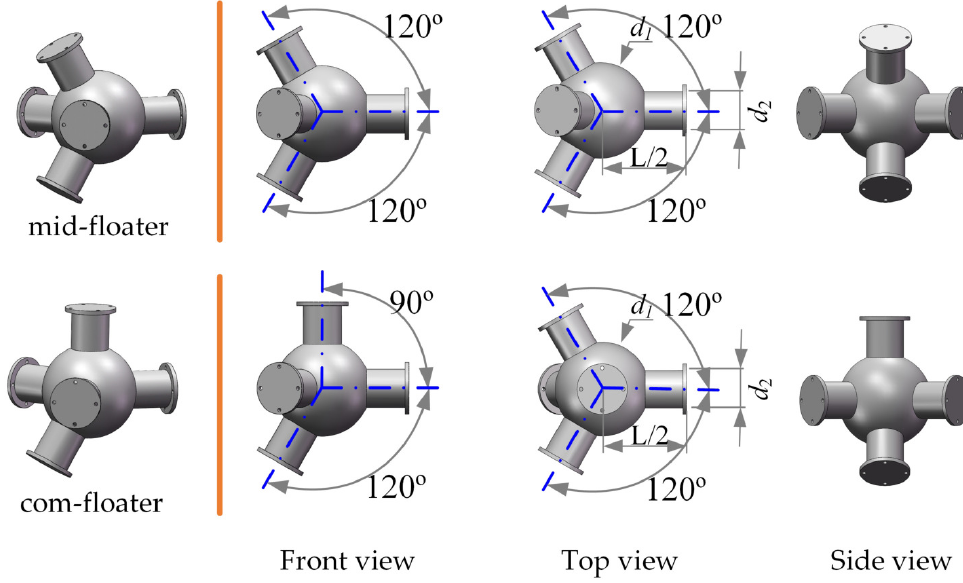
Figure 3. Details of the mid-floater and the